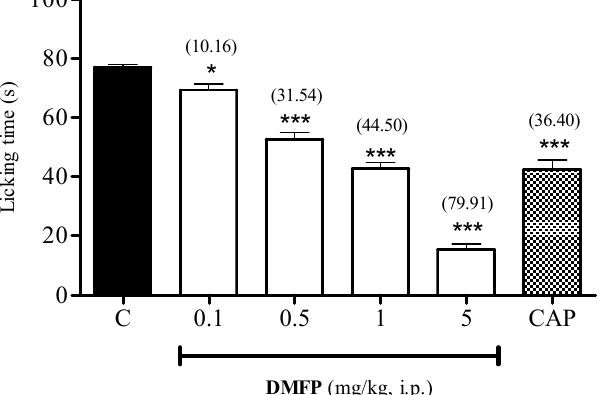
Figure 5. Effect of DMFP against capsaicin-induced paw-licking test in mice. Each column represents the mean ± S.E.M. of 6 mice. The mice were pre-treated with vehicle (C, 10 mL/kg, i.p.), DMFP (0.1, 0.5, 1.0 and 5 mg/kg, i.p.) or capsazepine (CAP, 0.17 mmol, i.p.) 30 min before intraplantar (i.pl.) injection of capsaicin (1.6 μ g/paw, 20 μ L). The asterisks denote the significance levels * p < 0.05, *** p < 0.001, when compared with control group (one-way ANOVA followed by Dunnett’s post-hoc test). Values in parentheses are percentage of inhibition.